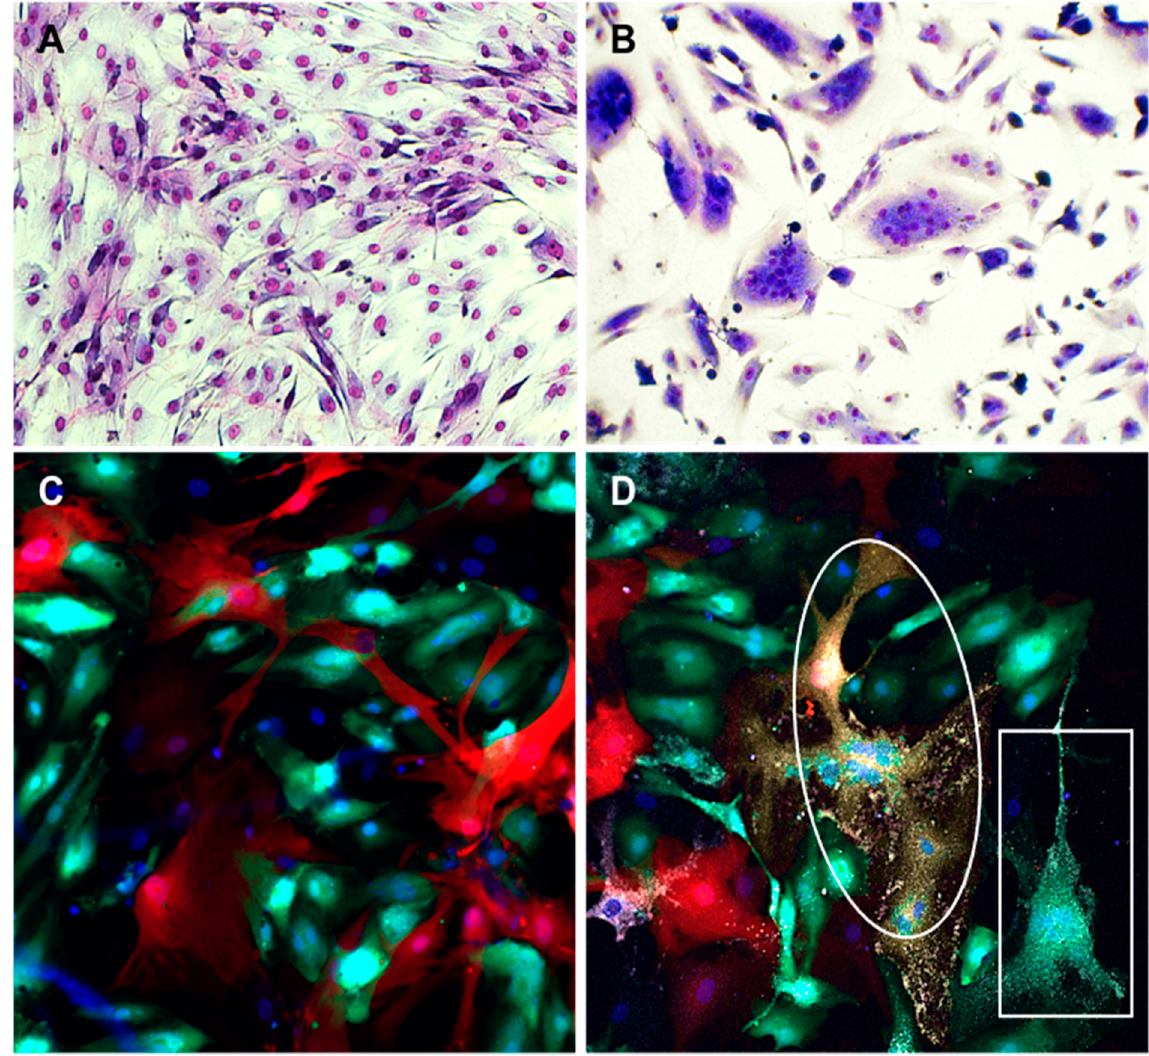
Figure 6. Fusion between SMC expressing NiV F and G and ECs. SMCs were transfected with plasmids encoding NiV F and G proteins and seeded in culture plates alone ( A ) or mixed with primary ECs (1:1) ( B ). Panels C and D show visualization of virus infection and syncytia in mixed cultures of SMCs and ECs. SMC and EC were transduced with lentivirus constructs expressing either RFP or GFP, respectively. After fluorescent protein expression was observed in almost all cells, SMCs and ECs were co-cultured for 24 h (1:1) and then either mock-infected ( C ) or infected with NiV at a MOI of 5 ( D ). Cells were fixed 18 h after infection and stained with anti-NiV NP antibody (white) and DAPI (blue). Syncytia were composed of colocalized RFP and GFP (oval), indicating that both SMCs and ECs were involved in fusion or only GFP (rectangle) showing fusion of ECs alone. All fusions contained NiV NP (white). Images were captured at 10× magnification ( A , B ) or 20× magnification ( C , D ).